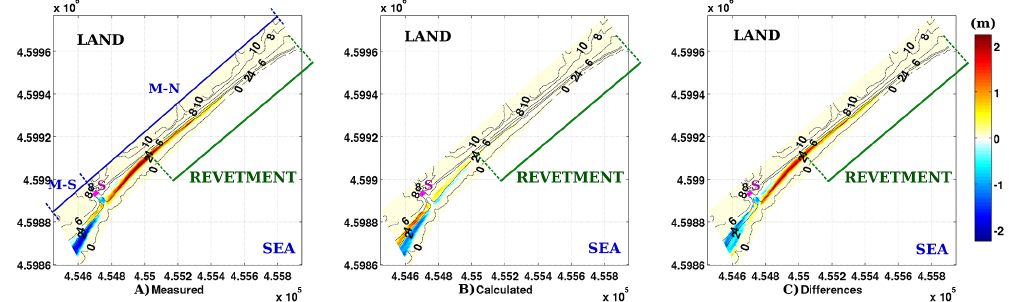
Figure 6. Topography of the emerged beach for the Mataró case. Contour lines represent the initial state of the coast. Colour scale: blue and red indicate accretion and erosion, respectively. Green (Gr) represents the revetment. Magenta (S) represents the stream discharge area. (a) Differences between the measured morphodynamic states (pre- minus post-storm conditions); (b) differences between the calculated morphodynamic states (pre- minus post-storm conditions); (c) differences between measured and calculated post-storm conditions. All units are in